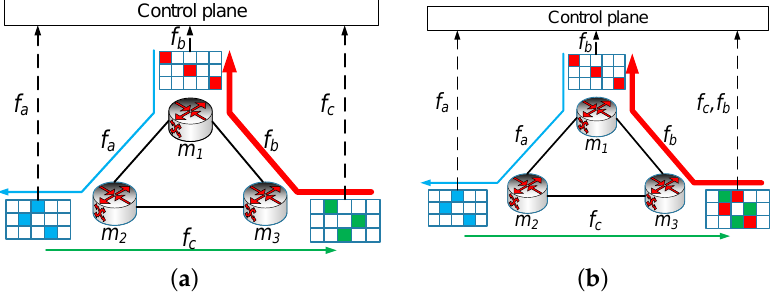
Figure 1. An example of network-wide measurements under a triangle topology. ( a ) Non-overlapped monitoring; ( b ) Collaborative